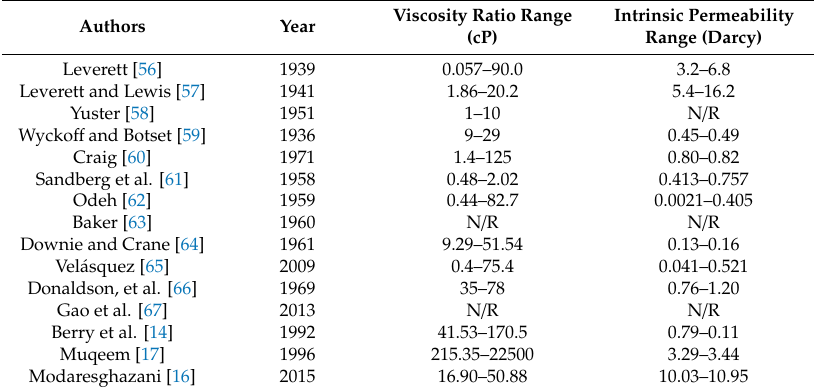
Table 3. Rock and fluid properties used in reported studies of the e ff ect of viscosity ratio on relative